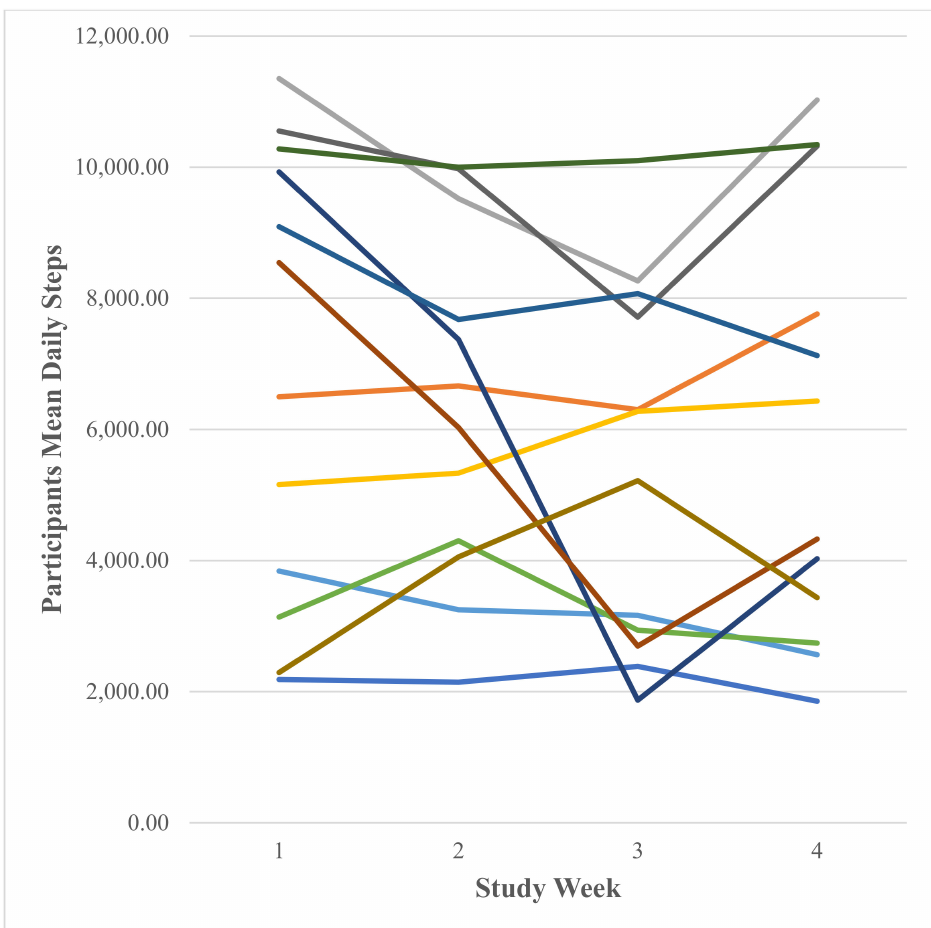
Figure 3. Individual participants’ mean daily steps as recorded via the Fitbit Charge 4 activity tracker (each coloured line represents one of the 12